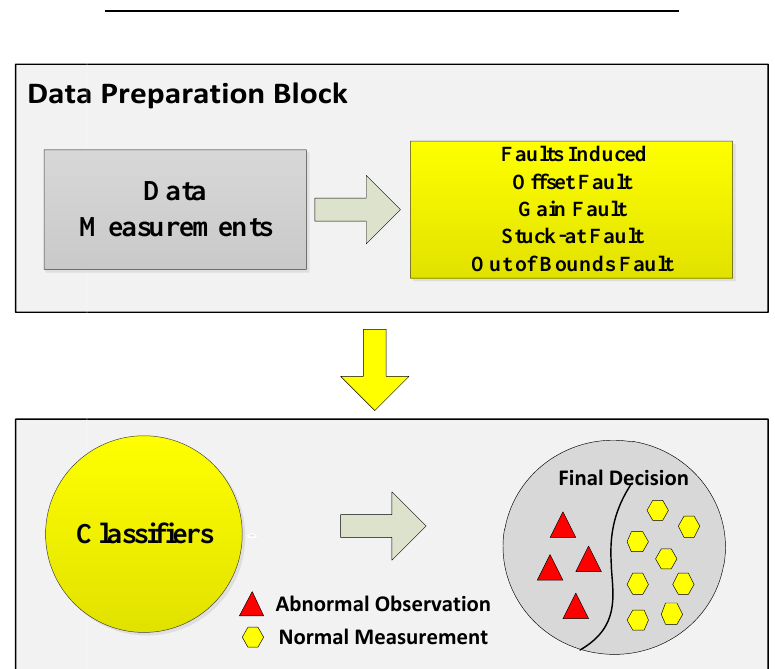
Figure 2. System model of fault detection.